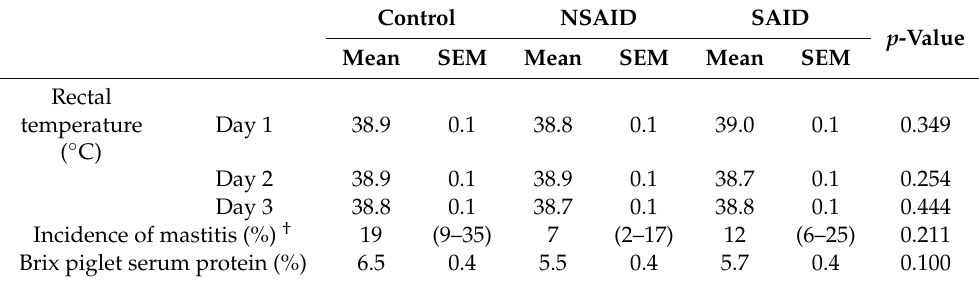
Table 1. The effect of saline (Control), a non-steroidal anti-inflammatory (NSAID), or steroidal anti-inflammatory (SAID) administration prior to farrowing on sow rectal temperature recordeddaily for three days post farrowing, the incidence (%) of mastitis (> 40 ◦ C) over the 3 day recording period, and Brix piglet serum protein (%) at 24 h of age (mean ± SEM). † 95% Confident intervals presented rather than SEM for binary data.